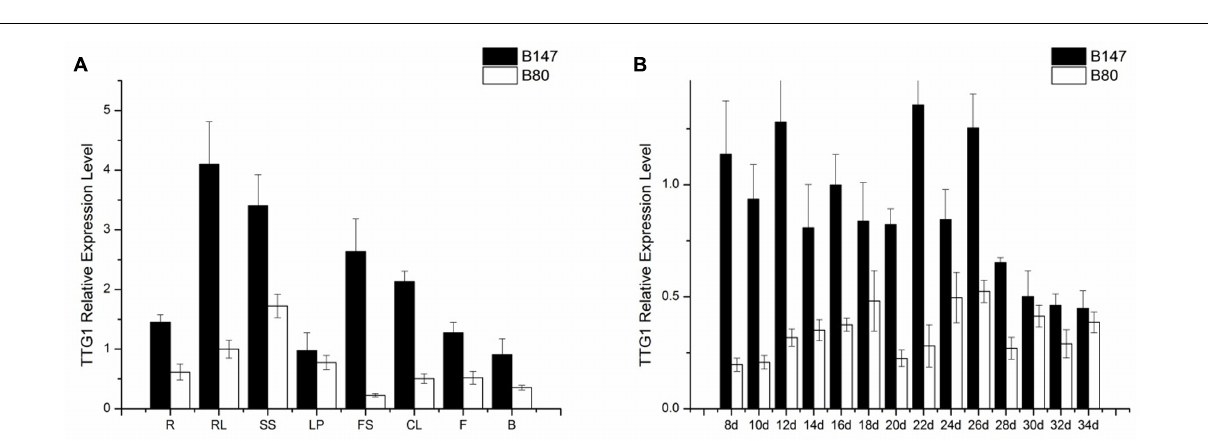
FIGURE 4 | Expression level of BrTTG1 in brown-seeded line B147 and yellow-seeded line B80. (A) Expression level of BrTTG1 in different tissues (R, root; SS, shorted stem; RL, rosette leaf; LP, leave petiole; FS, flower stem; CL, cauline leaf; F, flower; and B, bud). (B) Expression level of BrTTG1 in seed of B147 and B80 at different ripening period (8, 10, 12, 14, 16, 18, 20, 22, 24, 26, 28, 30, 32, and 34